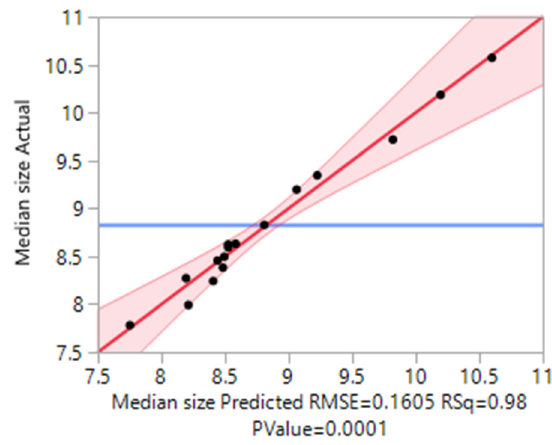
Figure 6. Predicted versus experimental responses.